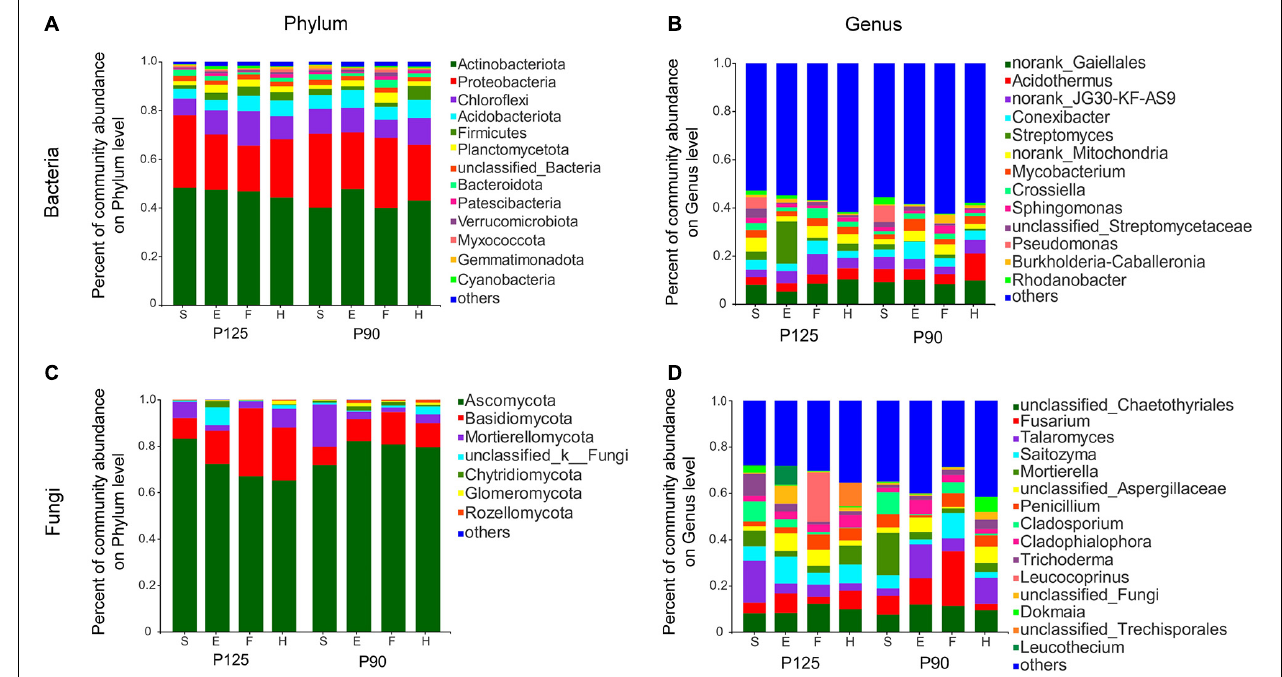
FIGURE 3 | Community composition of bacteria and fungi in four growth stages—seedling stage ( S ), ear stage ( E ), flowering stage ( F ), and harvest stage ( H )—under conventional treatment (P125, with a rate of 125 kg P 2 O 5 ha − 1 ) and optimal treatment (P90, with a rate of 90 kg P 2 O 5 ha − 1 ). (A,B) Bacterial community composition at the phylum and genus levels. (C,D) Fungal community composition at the phylum and genus levels. Columns of different colors represent different species; the length of the columns represents the proportion of the